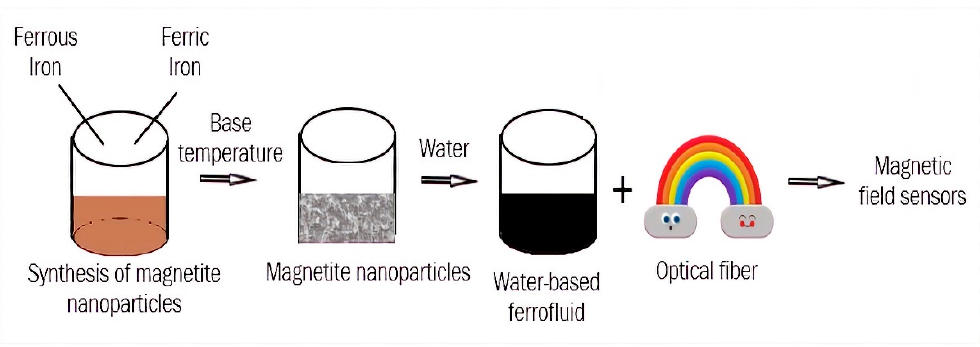
Figure 14. Application of magnetic ferrofluids for fabrication of magnetic field sensors.